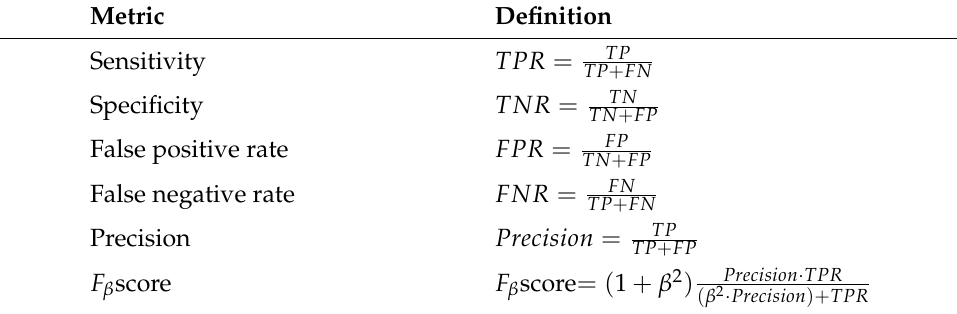
Table 3. The quantitative